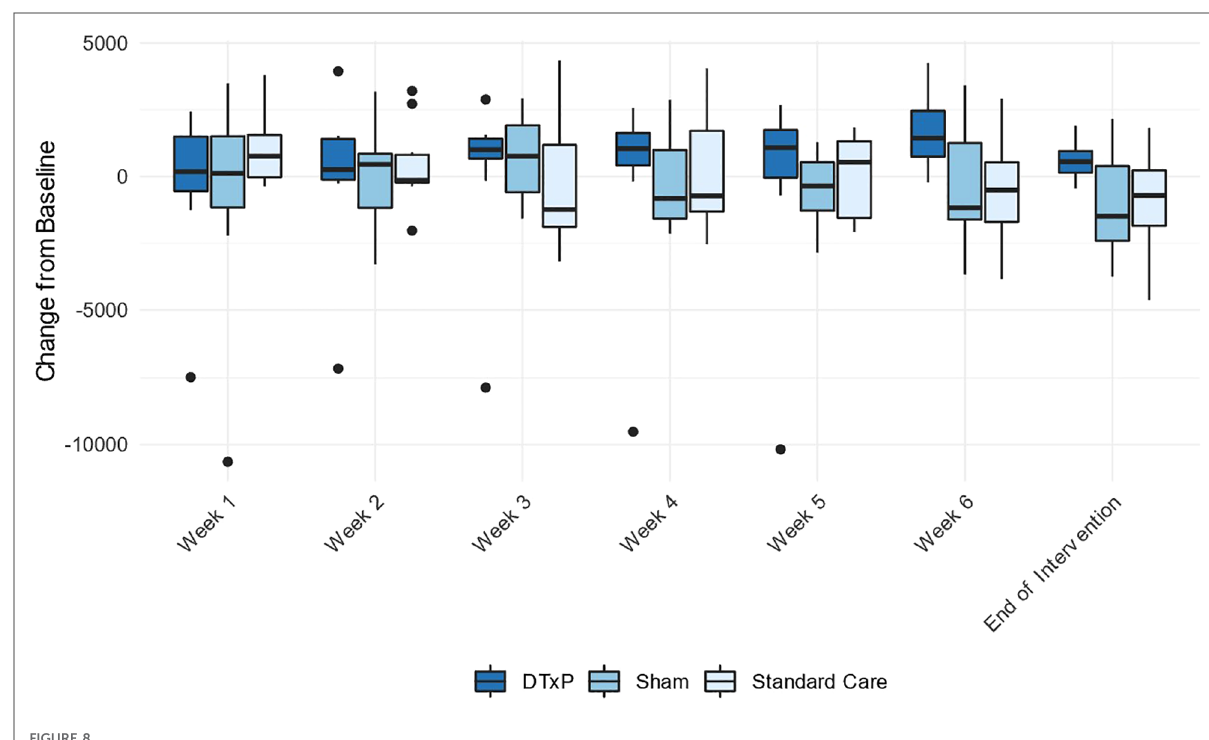
FIGURE 8 Average steps per day by study